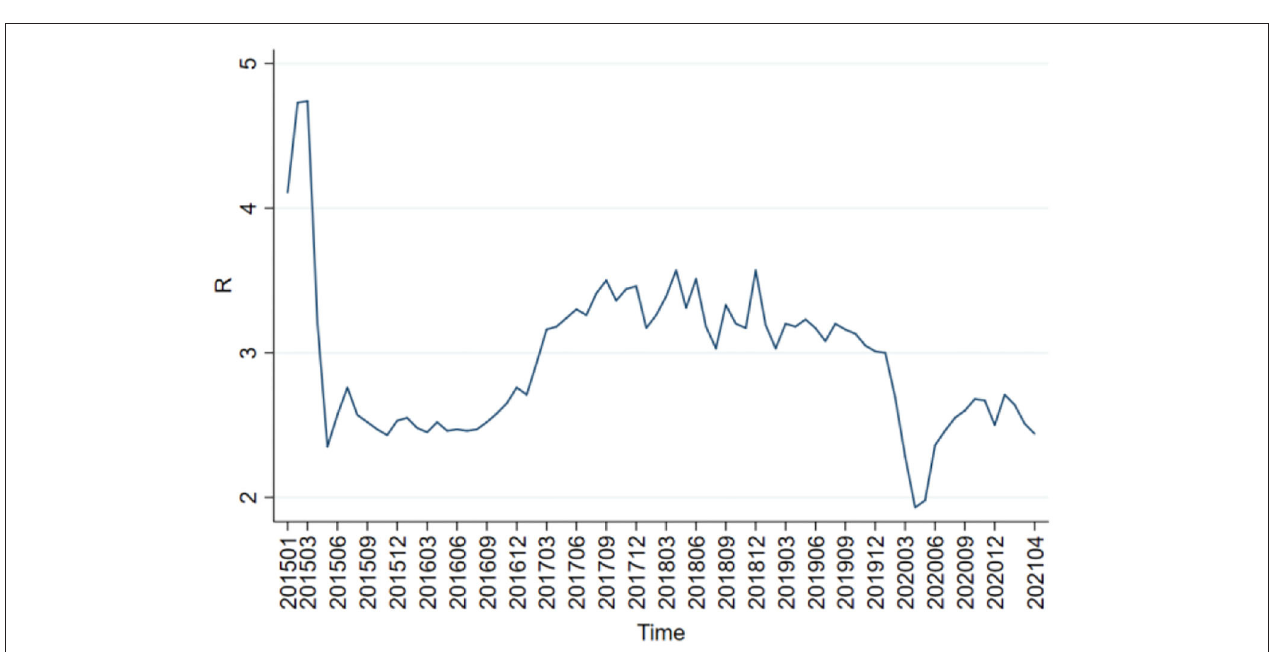
FIGURE 2 | Trend chart of the weighted average of the 7-day interbank